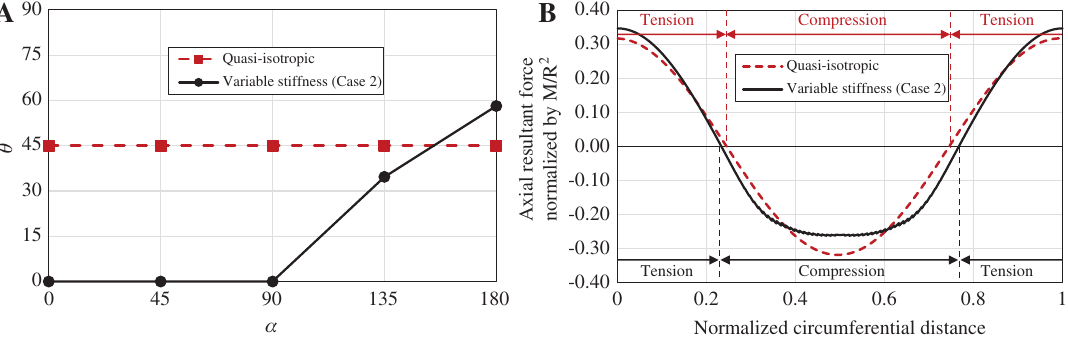
Figure 5: (A) Optimum orientation angle distribution of steered plies and their counterparts in QI laminate and (B) resultant normal section force in QI and VS cylinder (case